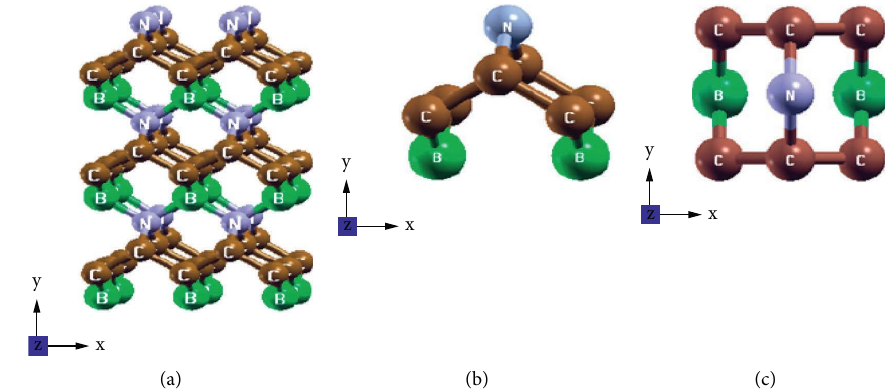
Figure 1: Optimized crystal structure of type II orthorhombic BC × 2 × 3, (b) a side view of unit cells 2 N: (a) supercells of o-BC 2 N of 22 of o-BC 2 N, and (c) a top view of unit cell crystal structures of o-BC2N, with the green color representing boron (B), the brown color representing carbon (C), and the light blue color representing nitrogen (N).